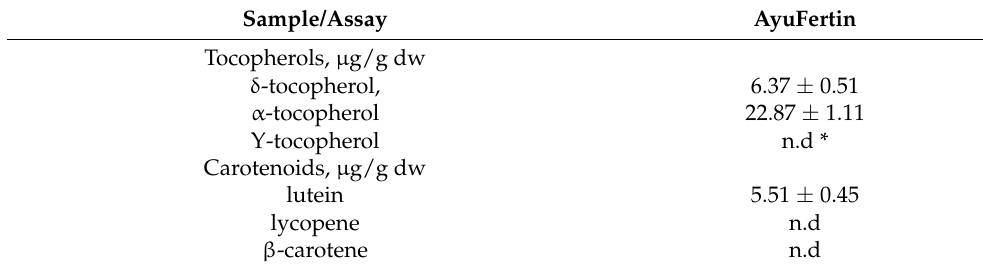
Table 1. Tocopherols ( µ g/g dw) and carotenoids ( µ g/g dw) content of